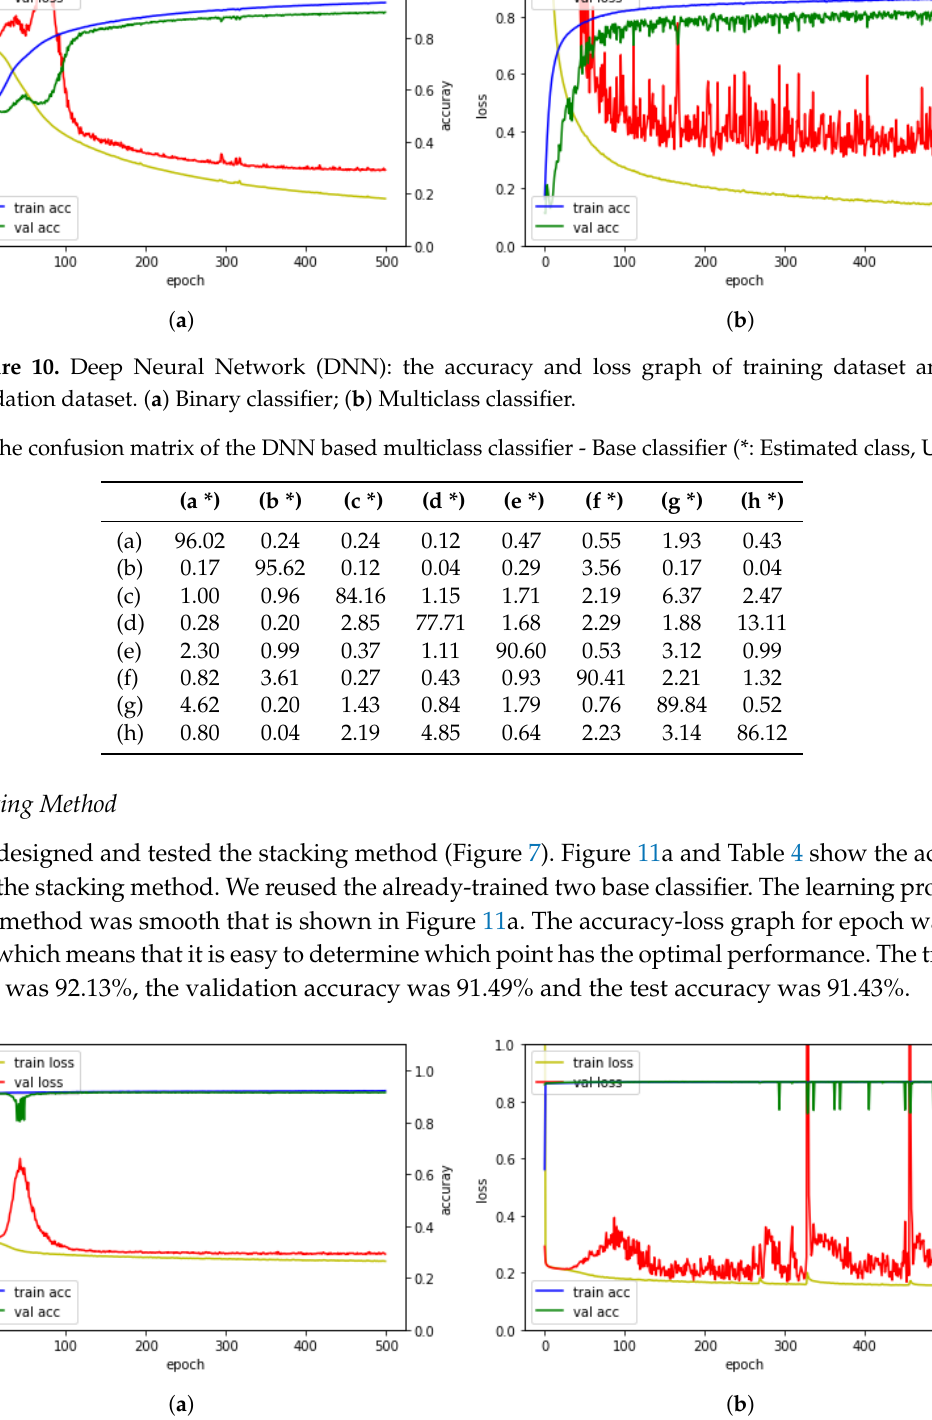
Figure 11. The accuracy and loss graph of training dataset and validation dataset. ( a ) Stacking method; ( b ) Modified